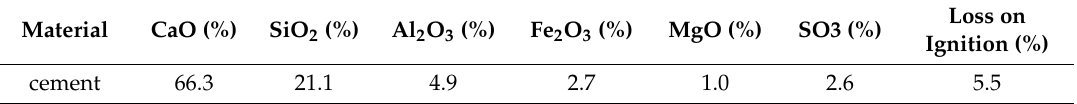
Table 2. Chemical composition of Portland cement CEMII/ A-L 32.5